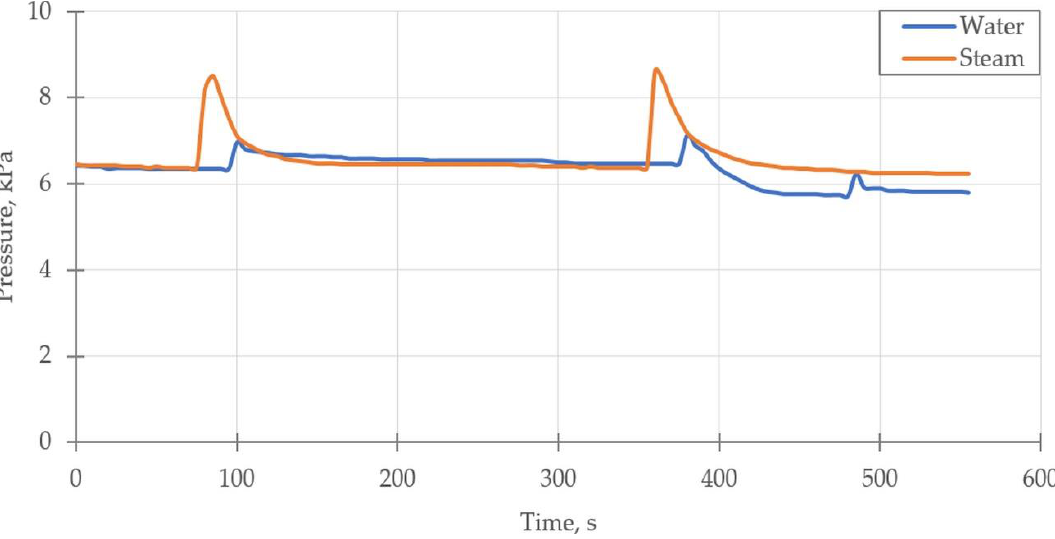
Figure 9. Pressure inside the condenser (P4).